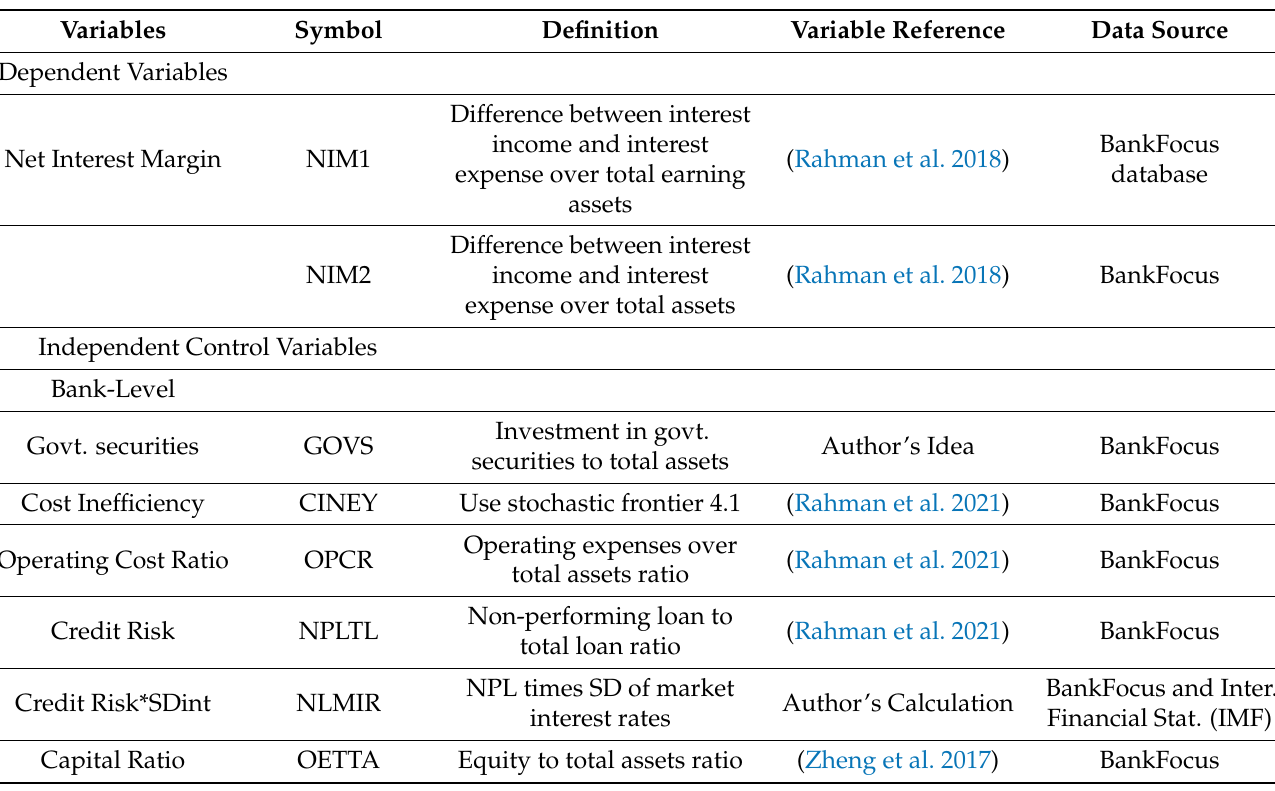
Table 1. Determinants of the cost of financial intermediation: Variable definitions.